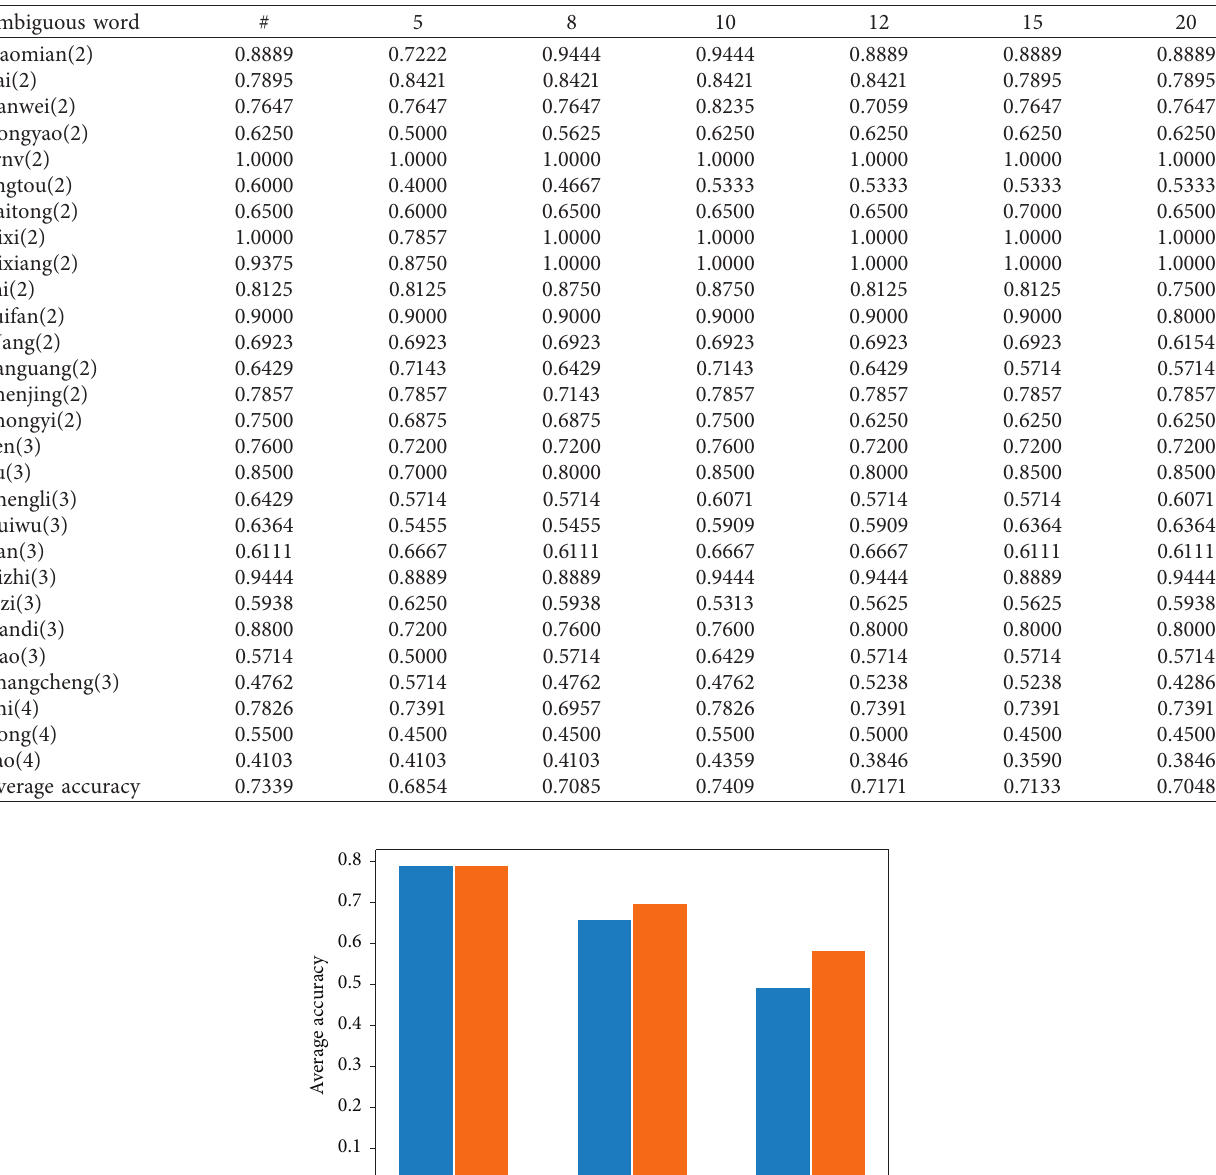
Table 3: Disambiguation accuracies in the third group of experiments.